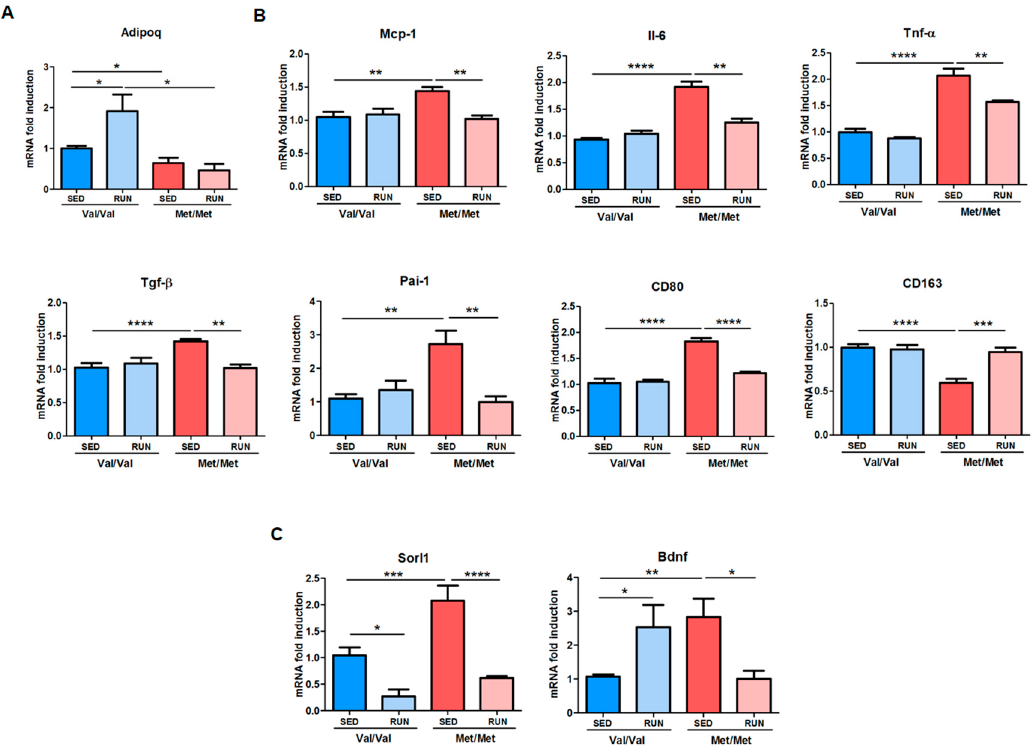
Figure 5. Impact of voluntary physical exercise (PE) on the gene expression profile of adipose tissue isolated from BDNF Val / Val and BDNF Met / Met mice. ( A ) Adipogenesis, ( B ) inflammation, and ( C ) BDNF / TrkB pathway related to mRNA levels in epiWAT of sedentary and running BDNF Val / Val and BDNF Met / Met mice. Data are expressed as mean ± SEM. n = 6 mice / group. Two-way ANOVA followed by Bonferroni post hoc analysis. * p < 0.05, ** p < 0.01, *** p < 0.005, and **** p <